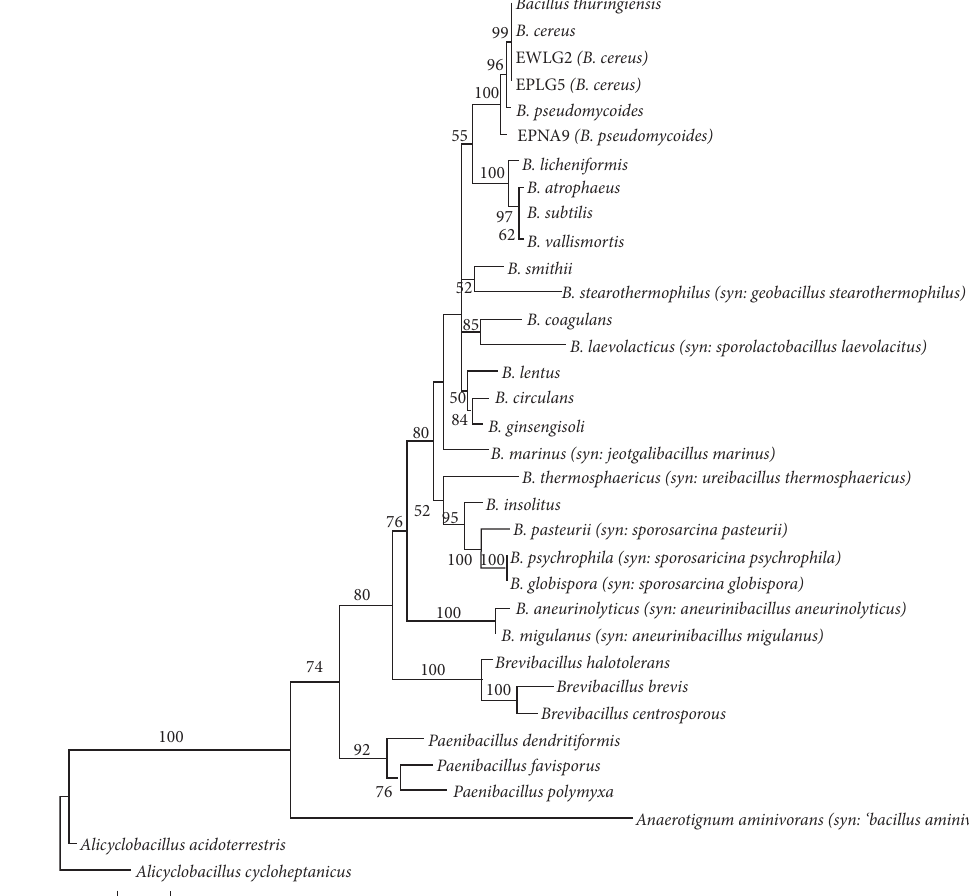
Figure 3: Neighbor-joining tree of the genus Bacillus based on 1331 nucleotides of the 16s rRNA gene using the GTR+I+ G model of DNA substitution. The tree is rooted on members of Paenibacillus, Brevibacillus, and Alicyclobacillus. Values on nodes represent percentage bootstraps out of 1000 bootstrap samples; values less than 50% are not shown. Scale bar represents five nucleotide substitutions for every one thousand nucleotides. The phylogenetic tree supports the BLASTidentity of the isolates as they cluster with the Bacillus cereus - and Bacillus pseudomycoides -type